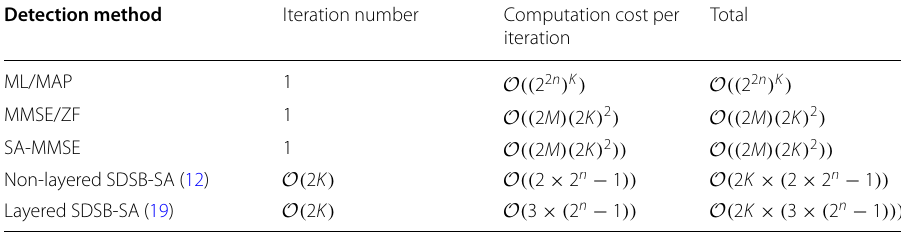
Table 2 Computation Complexity